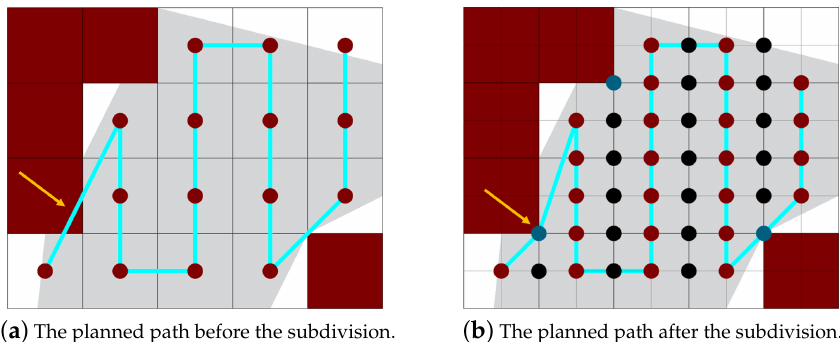
Figure 6. The difference between paths planned before and after the subdivision.